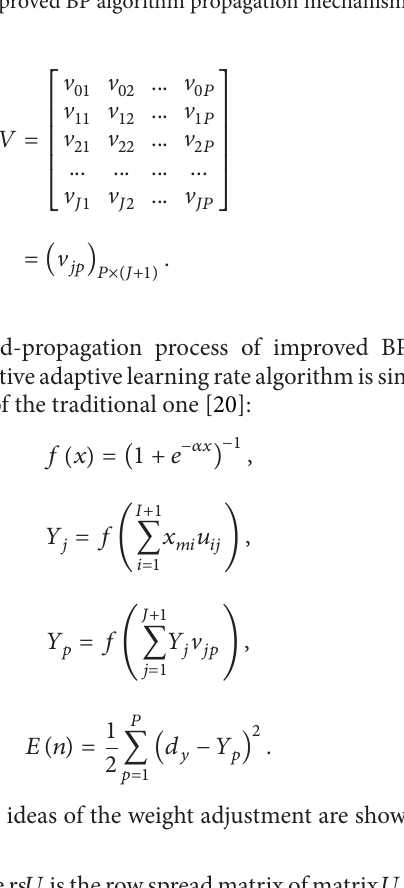
Figure 2: Improved BP algorithm propagation